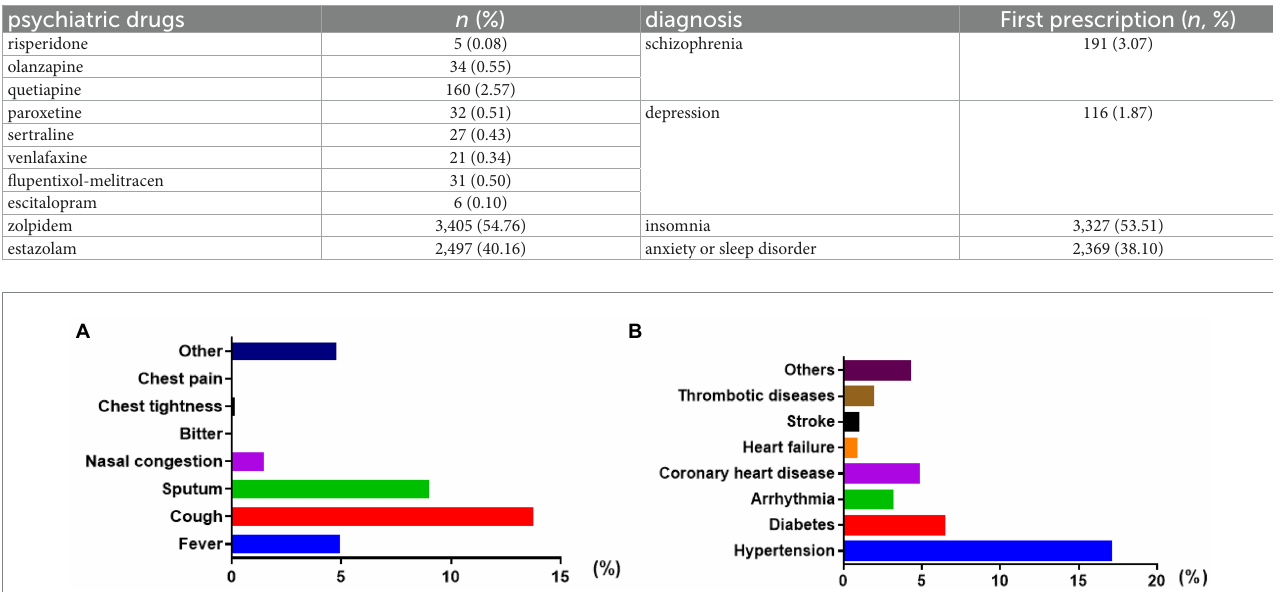
TABLE 1 The prevalence of infected patients needing administration of associated psychiatric drugs.